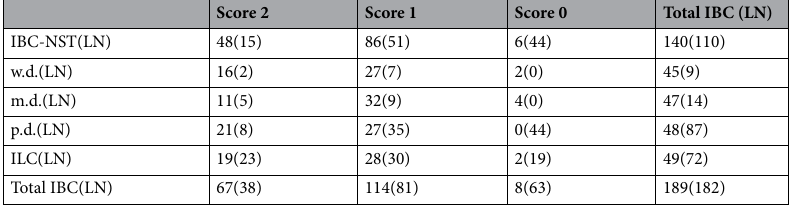
Table 1. Distribution of sCav-1 expression among IBC subtypes and corresponding lymph nodes (LN). IBC- NST invasive carcinoma of no special type, w.d. well differentiated, m.d. moderately differentiated, p.d. poorly differentiated, ILC invasive lobular